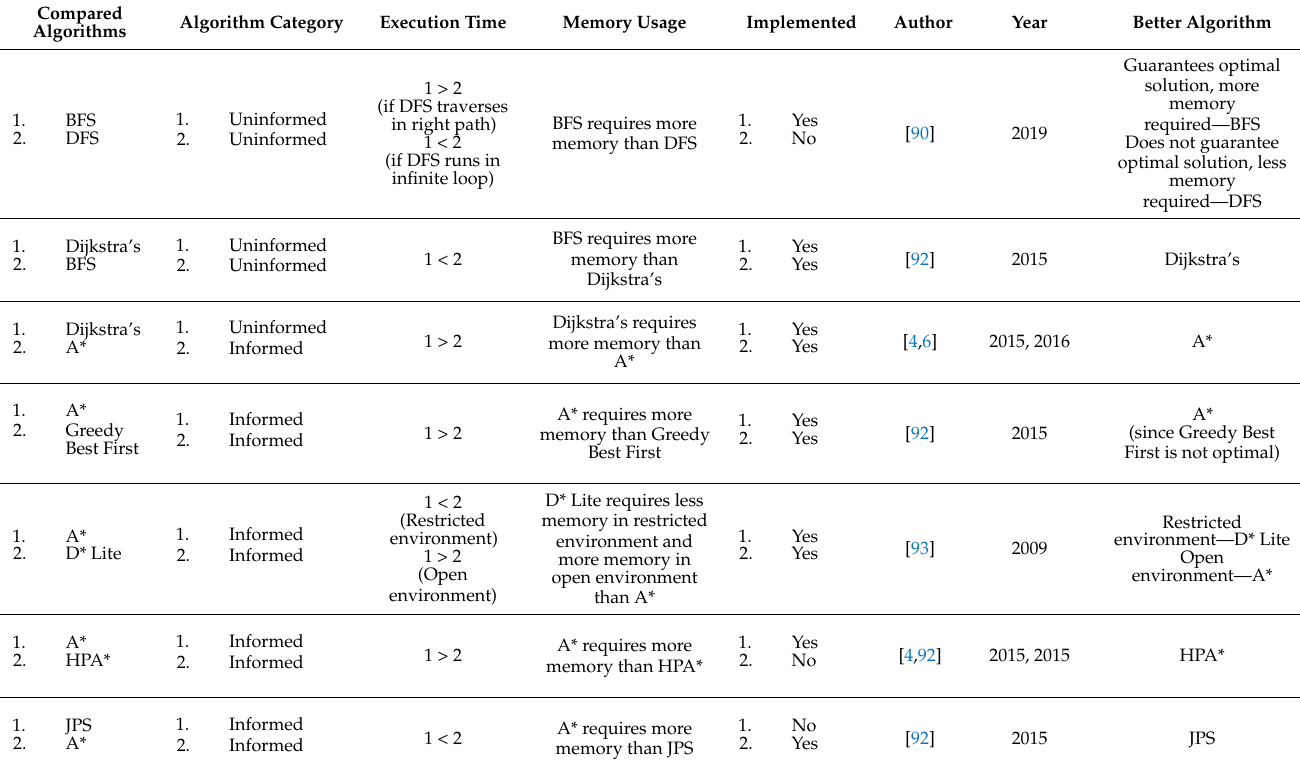
Table 5. Final summary of pathfinding